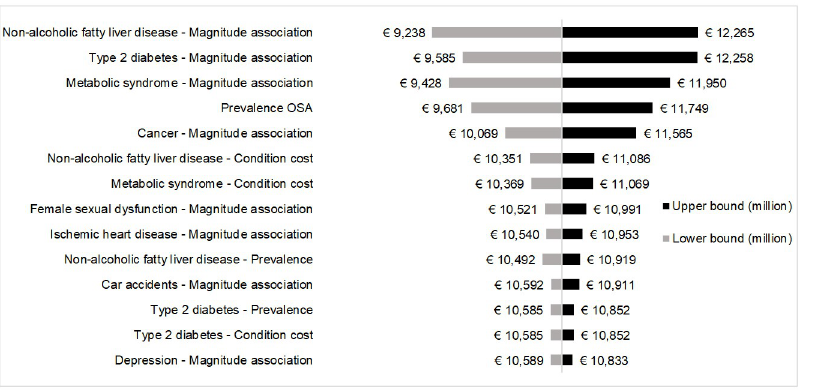
Fig 3. Tornado plot for sensitivity analysis (model